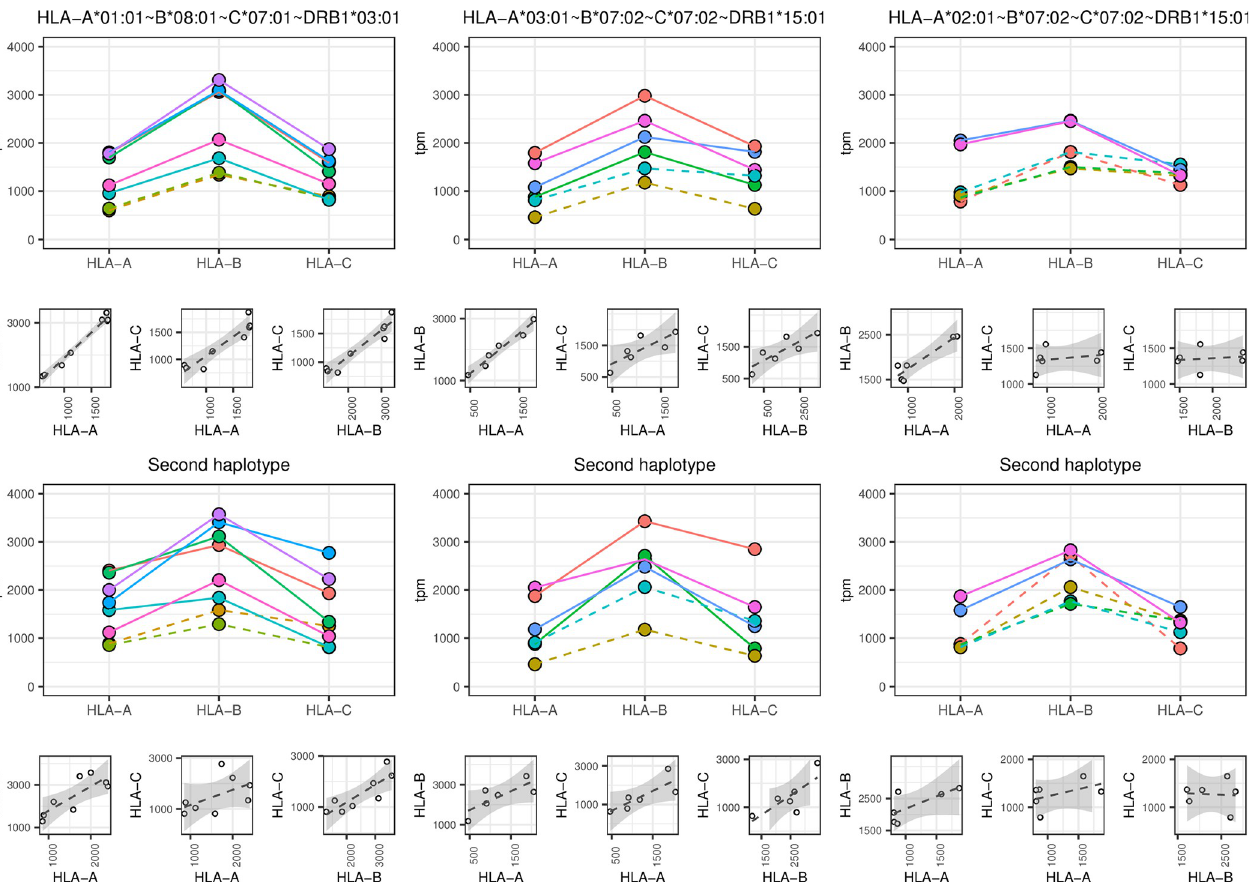
Fig 4. Allelic expression in PBMC carrying common HLA haplotypes. The upper panels represent the RNA expression (in tpm) of alleles segregating on three common HLA haplotypes as indicated. In the lower panels, the RNA expression (in tpm) of the alleles belonging to the second haplotype is shown. Each individual carrying a given haplotype is shown with a different color code. Straight and dotted lines correspond to RNAs of cells kept in culture without stimulation overnight or of freshly isolated PBMCs, respectively. The HLA-typing of the second haplotype differ between samples sharing a common haplotype. Small facets represent the pairwise linear regression of expression between loci. The standard error of the regression is indicated as grey shedding.